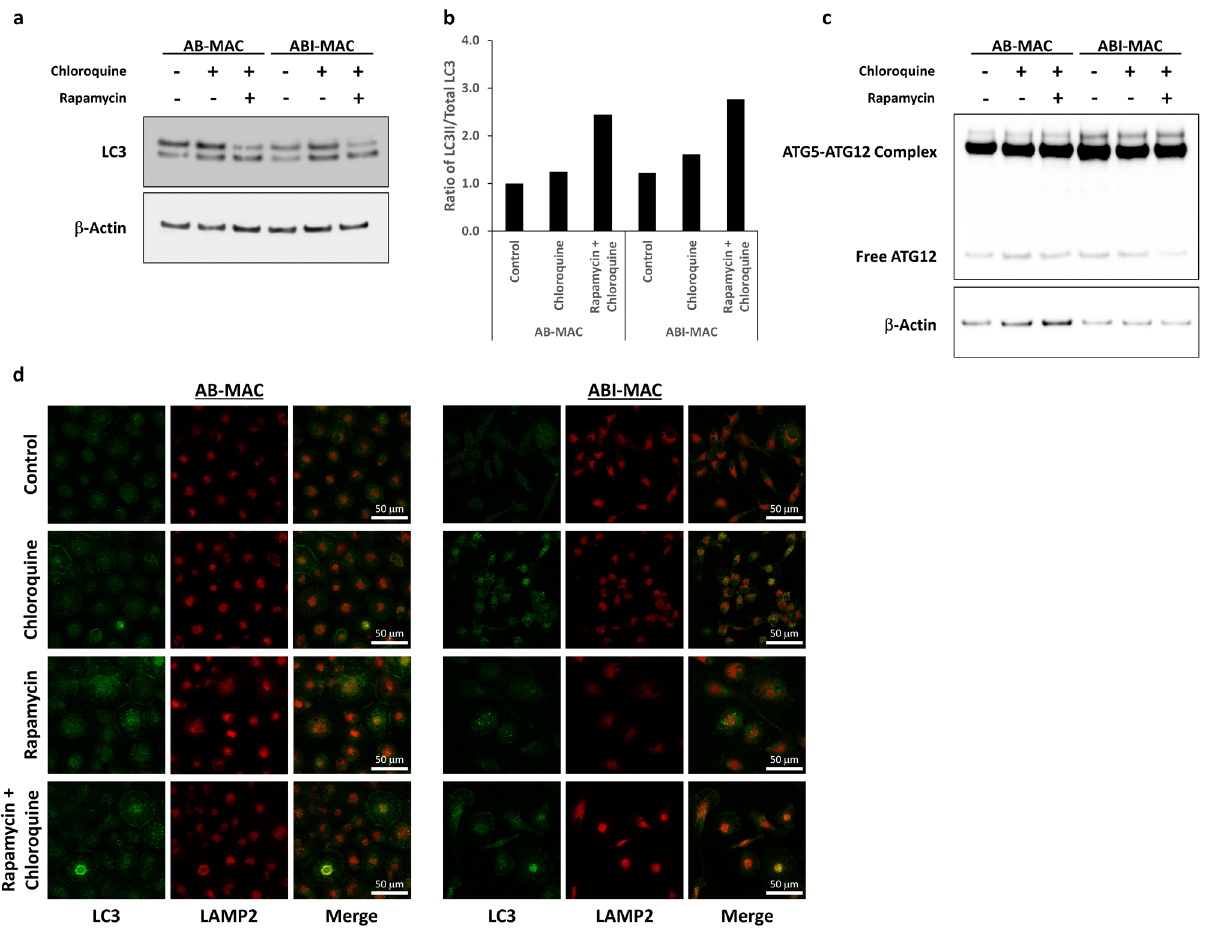
Figure 4. IL-27–induced autophagy is LC3-independent. AB-MAC and ABI-MAC were seeded in 6-well plates (1.5 × 10 6 cells /well) and incubated overnight in complete medium with or without either chloroquine or a combination of chloroquine and rapamycin as described previously. ( a ) Total cell lysates were separated on a 4–12% Bis–Tris gel in MES buffer (Thermo Fisher) and transferred onto a 0.2 μm nitrocellulose membrane, which was cut into two pieces along the 31 kDa marker. LC3 and β-Actin were detected by western blot. Results display representative blots from a single donor; LC3-I corresponds to the diffuse, cytoplasmic form of LC3, while LC3-II is the lipidated, phosphatidylethanolamine-coupled form of LC3, incorporated into autophagosomes. Original blot images are displayed in Supplementary Fig. S11. ( b ) Densitometry analysis of LC3 lipidation, as described prior; graph displays densitometry ratios of lipidated LC3 (LC3-II) to total LC3 (LC3-I + LC3-II). Representative blots from a single donor. ( c ) Cell lysates were subsequently run on a 4–12% Bis–Tris gel in MES buffer (Thermo Fisher) and proteins were transferred onto a 0.2 μm nitrocellulose membrane. ATG12 was detected by western blot and appears either as the ATG5-ATG12 complex (around 55 kDa) or as free ATG12. Results display representative blots from a single donor, original blot images are displayed in Supplementary Fig. S12. ( d ) AB-MAC and ABI-MAC were incubated overnight onto 15 mm coverslips in 12-well plates (6 × 10 5 cells/well) and were either left untreated (Control) or treated with Chloroquine, Rapamycin, or a combination of both drugs. Cells were then fixed, permeabilized and stained with antibodies against LC3 (green) and LAMP2 (red); LC3-I displays a diffuse cytoplasmic staining while LC3-II exhibits a punctate